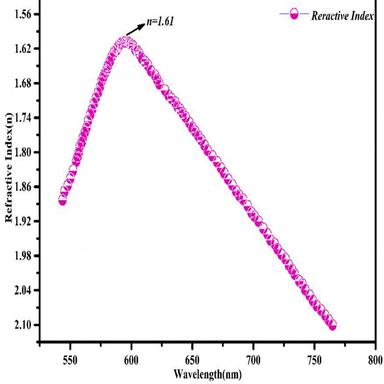
Refractive index vs wavelength of La2SrFe2TiO9.